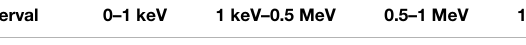
FIGURE 5 | Simulation model.